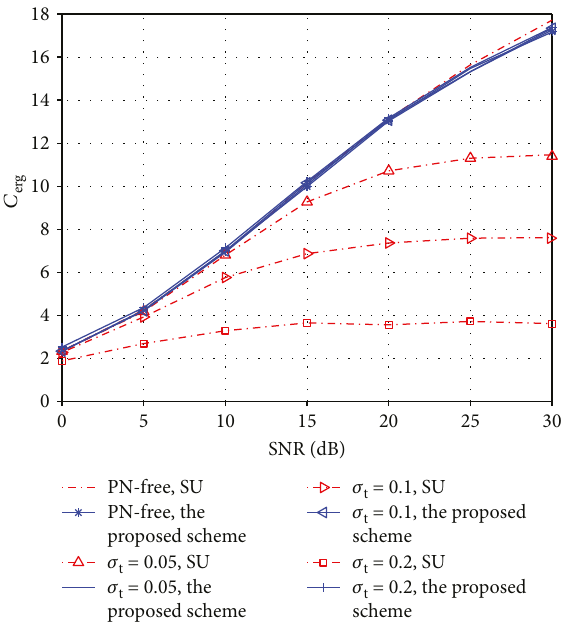
Figure 7: The ergodic capacity comparison between the proposed scheme and single-user (SU) scheme for the massive MIMO-OFDM uplink system. χ = 1 . Figure 7 when M = 300 and χ = 1 . The phase noise variance of LO at the transmitter and receiver is the same, σ